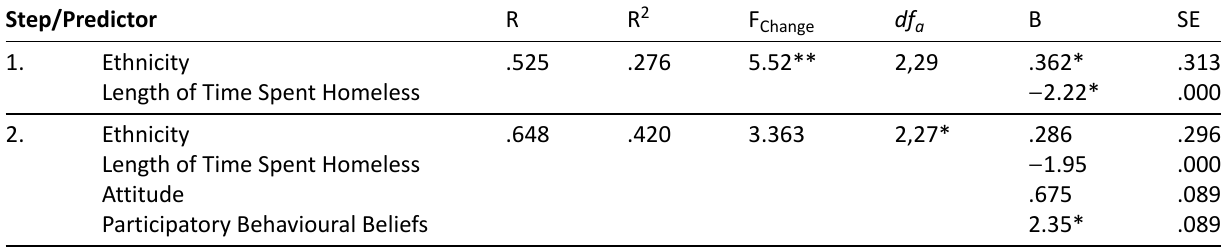
Table 4. Hierarchical multiple regression analysis predicting future service use intentions ( n = 33; low prior service use